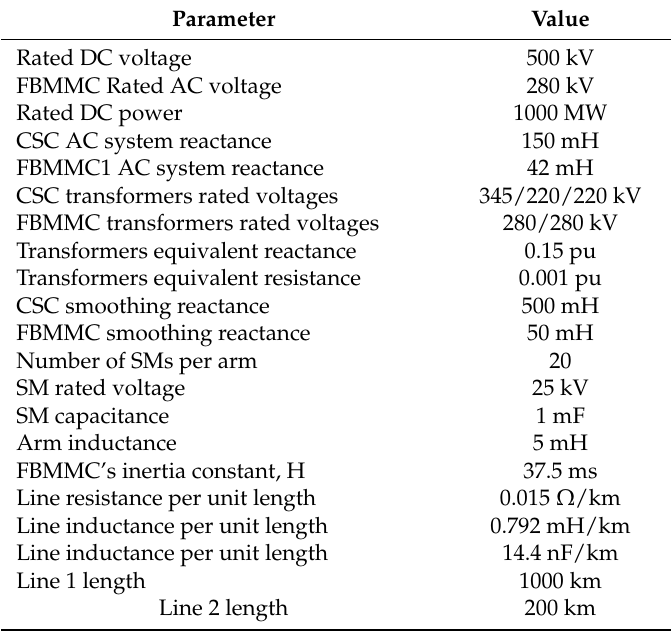
Table 1. Analyzed H 2 VDC System